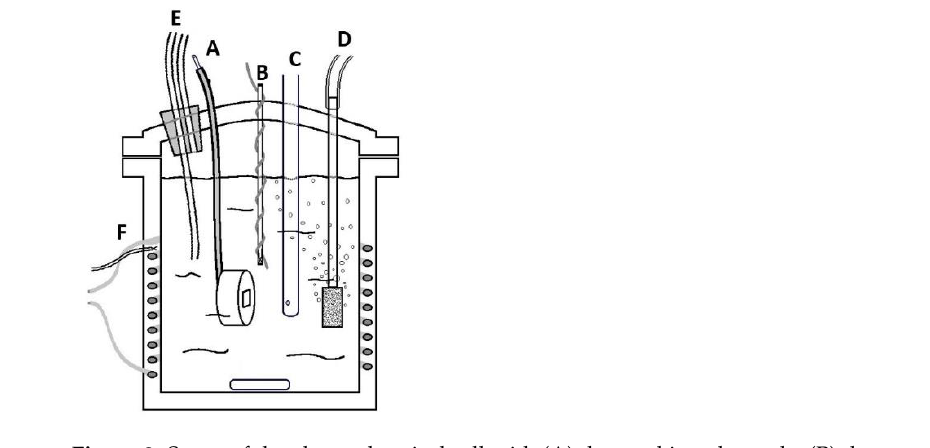
Figure 2. Setup of the electrochemical cell with (A) the working electrode; (B) the counter electrode;